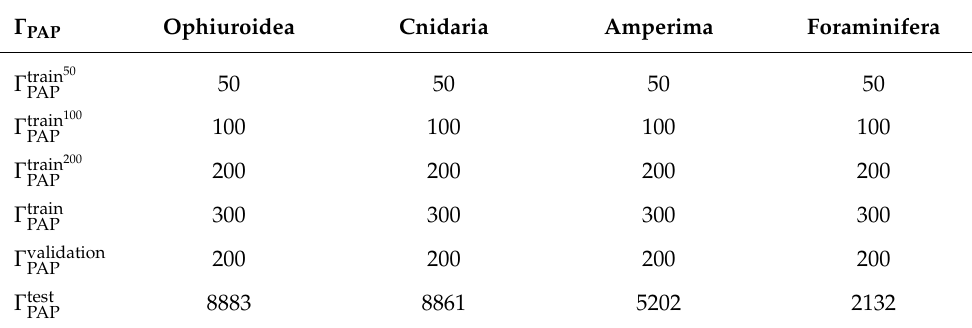
Figure 3. Construction of the training sets. Experiments were conducted using training sets of different sizes to investigate the influence of training set size on the impact of augmentation. Table 1. Sample sizes of each category per subset in the Γ PAP dataset.